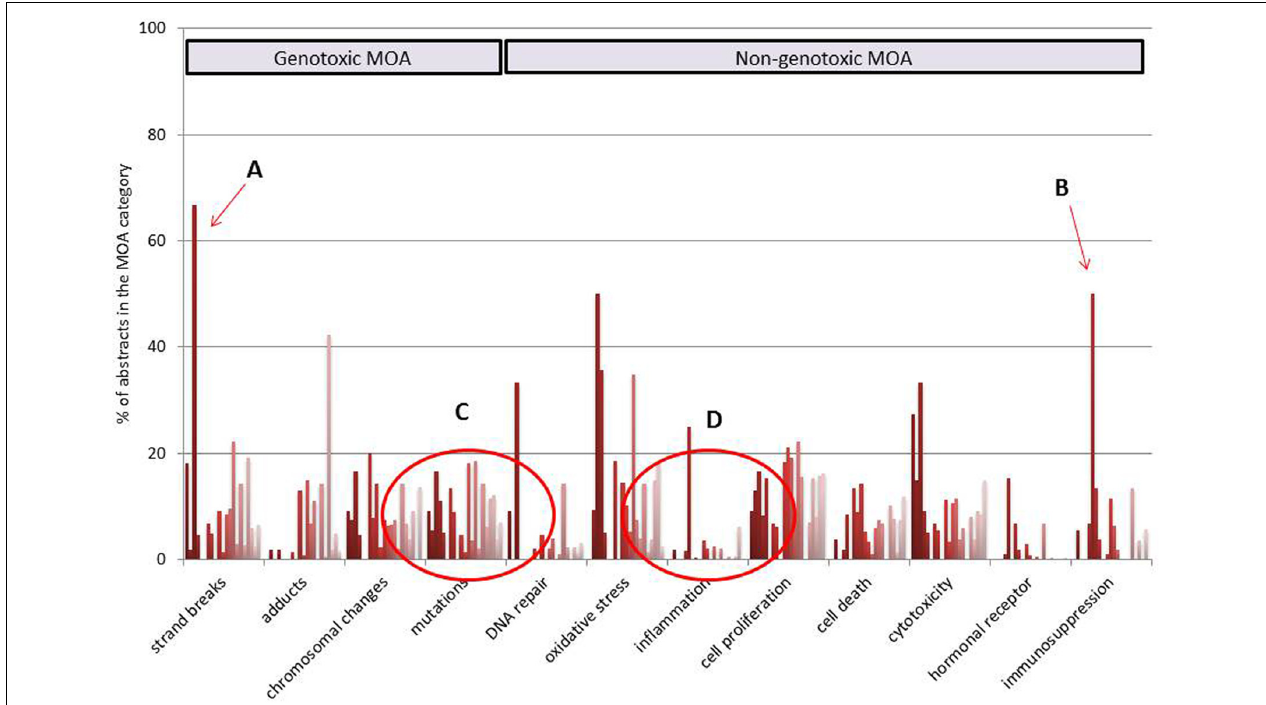
FIGURE 1 | Individual literature profiles of 21 rat carcinogens of the hematopoietic system. Twelve selected categories of carcinogenic MOA (modes of action) are shown.